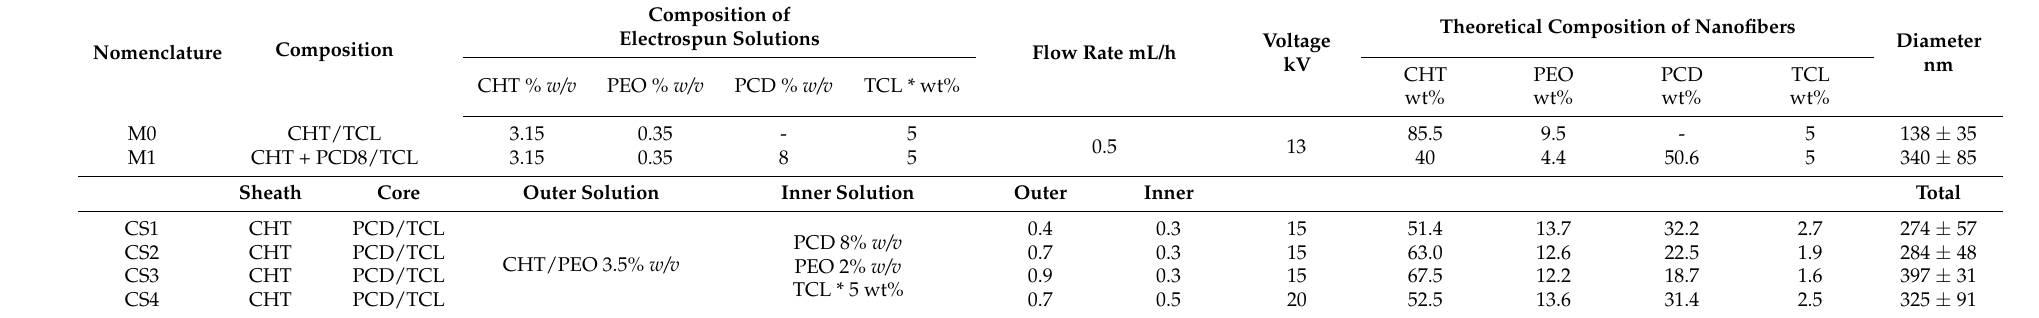
Table 1. Composition of the electrospun solutions and applied flow rates and voltages (on the left part); theoretical weight compositions of the loaded nanofibers and observed diameters (on the right